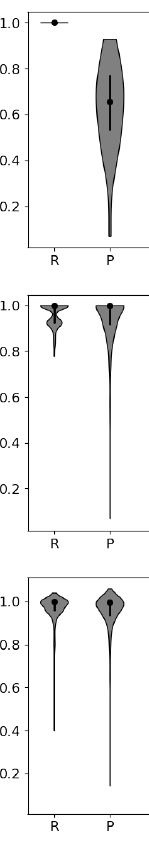
Figure 4. Precision, recall, and F1 scores for each peak within the ECG waveform from 10 participants selected at random. Each participant’s data comprise 32 different 10 s samples, half stressed and half unstressed. The shaded gray area shows the distribution of scores, the black dot shows the median value, and the thick black central line shows the interquartile range. The detection of the Q peak shows the lowest median scores and highest degree of variability between samples, making its detection